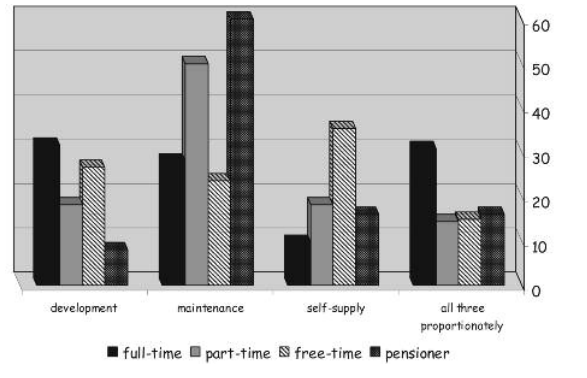
Figure 3. Relationship between farmer status and priorities, in the distribution of valid answers,